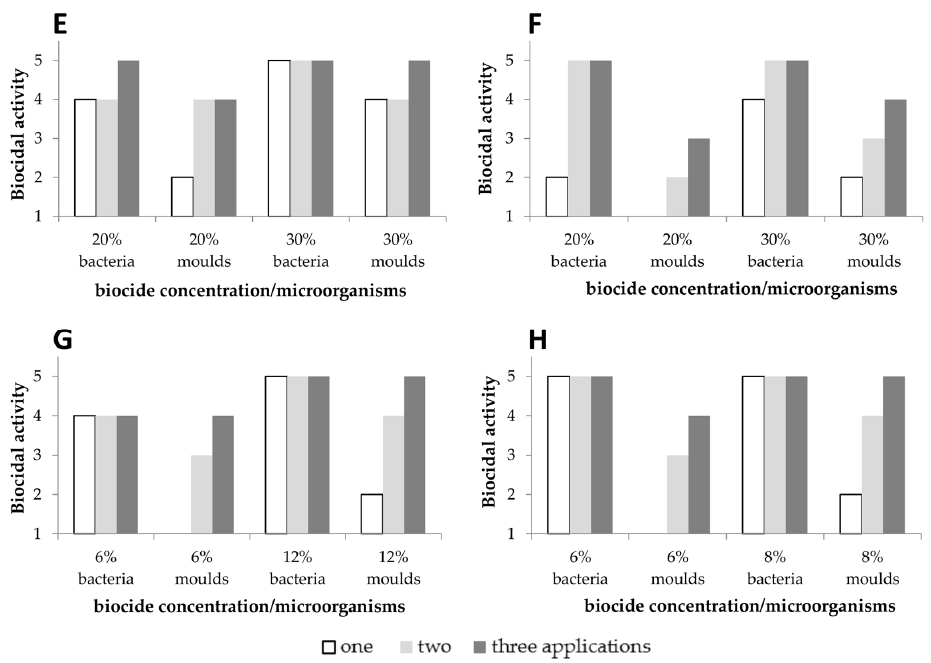
Figure 1. Effectiveness of disinfectants: ABM-1 ( A ); ABM-2 ( B ); Acticide LV 706 ( C ); Atoxyn ( D ); Boramon ( E ); Mycetox B’ ( F ); Preventol R80 ( G ); and Rocima 101 ( H ) against mixed populations of bacteria and moulds on wood: one (white bar graph), two (grey bar graph) and three (dark grey bar graph) applications.